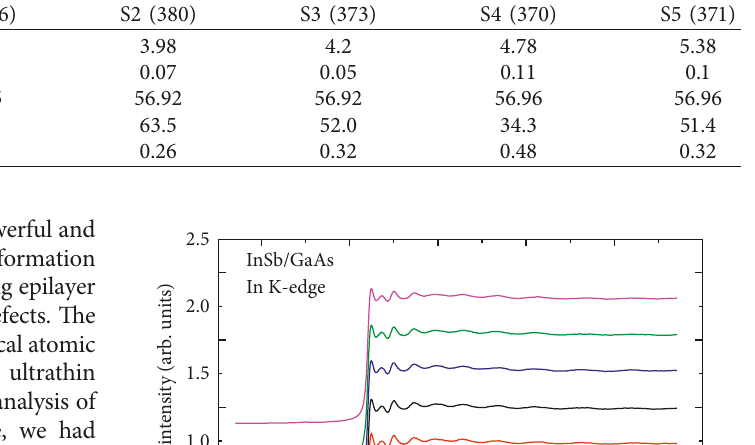
Table 2: The fitting and calculation results from XRD of five InSb samples with different V/III ratios. Sample no.